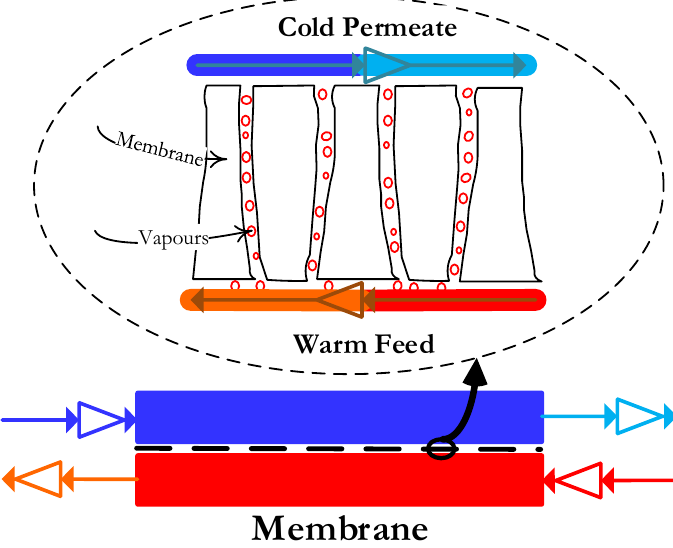
Figure 4. Schematic diagram of Direct Contact Membrane Distillation (DCMD) mechanism.